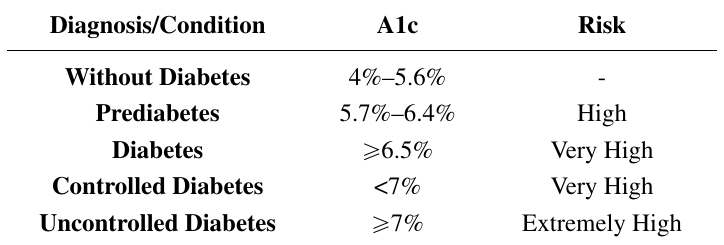
Table 3. A1c Assessment for the Diagnosis of Prediabetes and T2D.